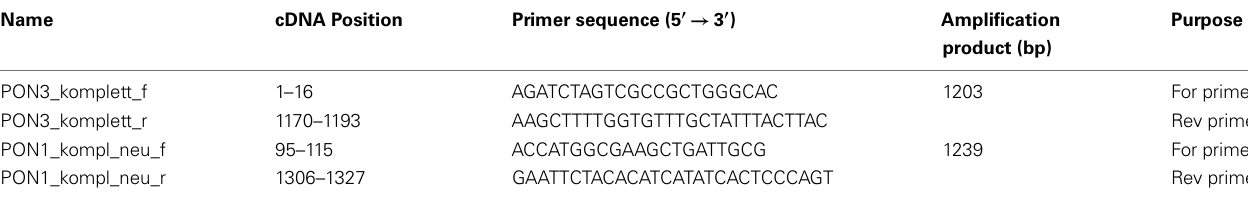
TableA3 | Amplification primers used for plasmid generation.